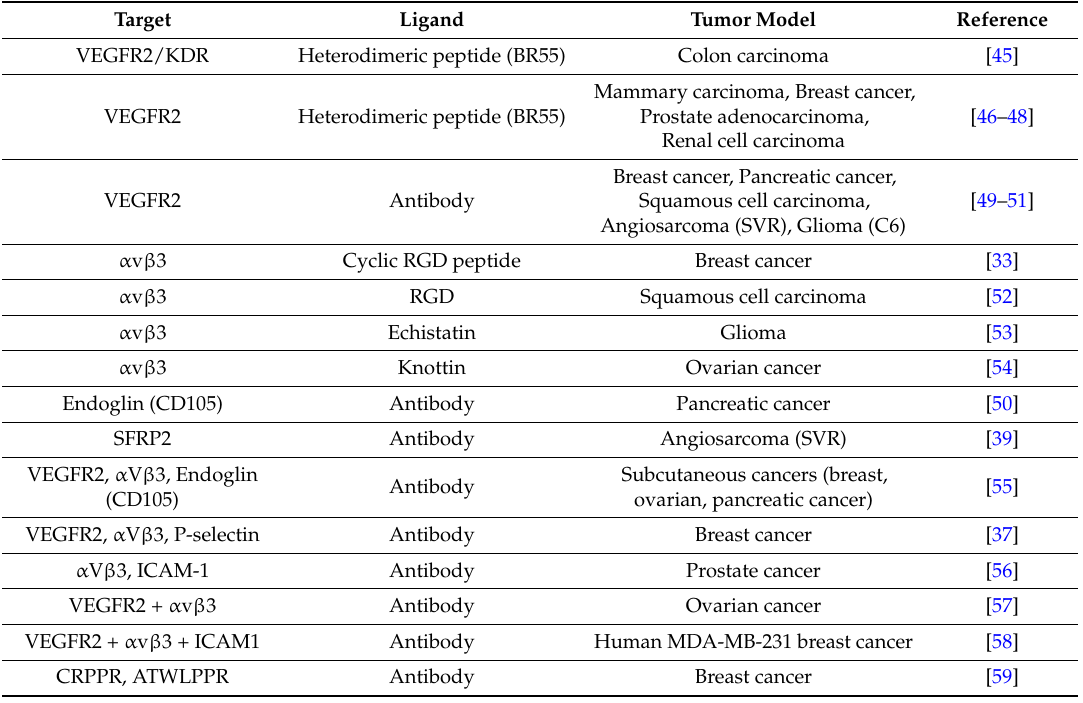
Figure 3. Comparison of before and after i.v (intravenously) injection of ( A ) AlgNC; and ( B ) CaCO 3 -AlgNC in vivo ultrasound imaging of tumors showed in the red outline; ( C ) Significant differences between contrast-enhanced ratio of CaCO 3 -AlgNC and AlgNC post-injection. *, p < 0.05, and #, p > 0.05. Note: Copyright 2016, American Chemical Society. Abbrevation: NC: nanocarrier. Table 2. Assessment tumor angiogenesis with different targeted microbubbles (MBs).